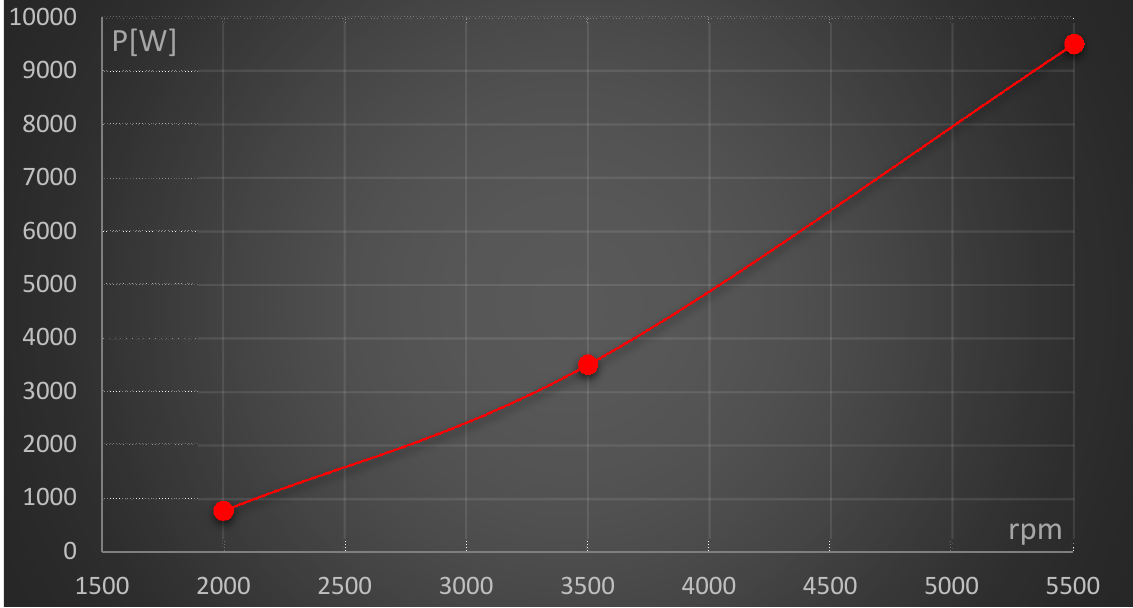
Figure 9. Power performance as a function of the speed of rotation of the ICE engine.